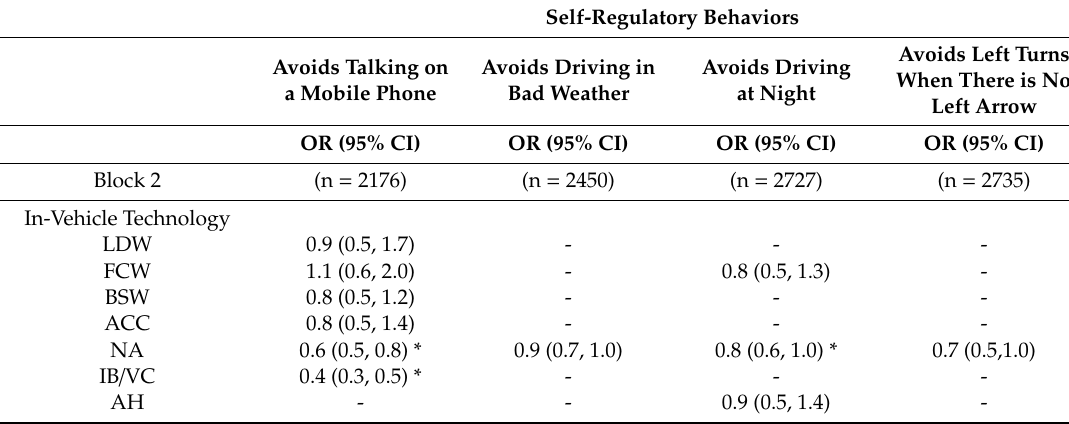
Table 6. Adjusted Odds Ratios (ORs) and 95% Confidence Intervals (CIs) from Hierarchical Logistic Regressions Exploring Relationship of IVTs and Self-Regulation (Block